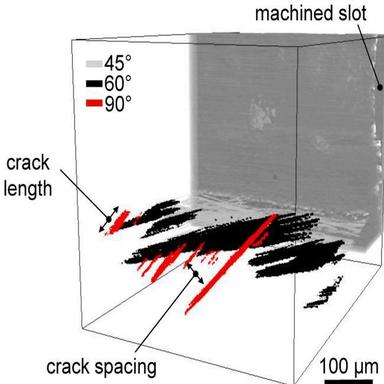
Magnified 3D view of the fracture surfaces inside the inset box shown in Fig. 8f.